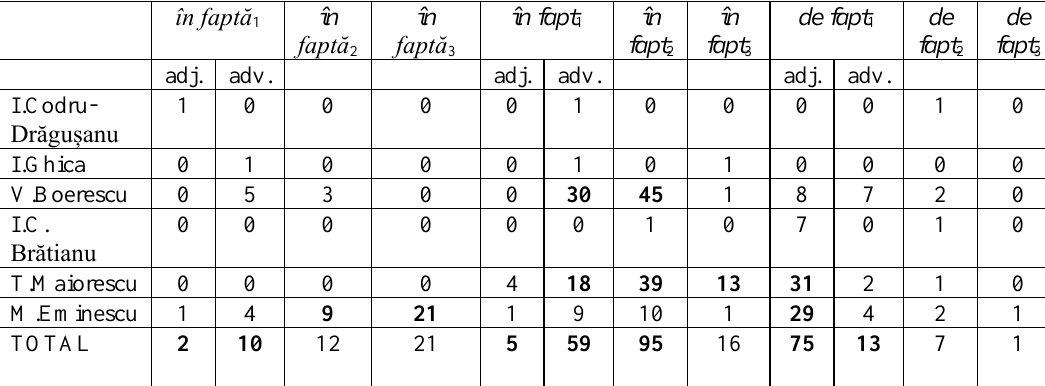
Table 2. În faptă , în fapt and de fapt in late 19 th